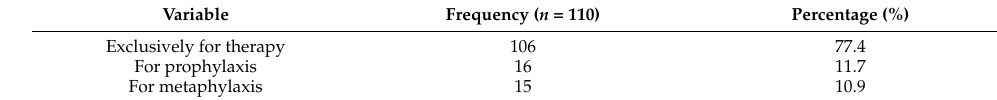
Table 10. Prescribing habits for antibiotics.